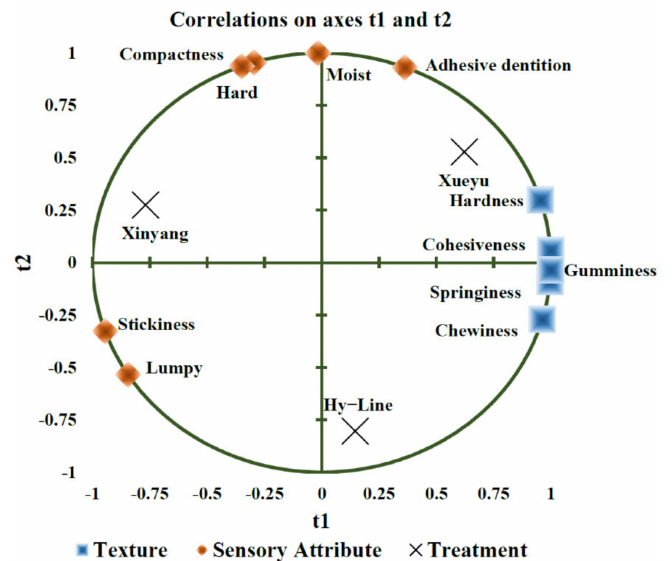
Figure 5. An overview of the correlation loadings from PLS analyses with texture as X-variables and sensory attributes as Y-variables. Note: Hy-Line: Hy-Line Brown; Xueyu: Xueyu White; Xinyang: Xinyang